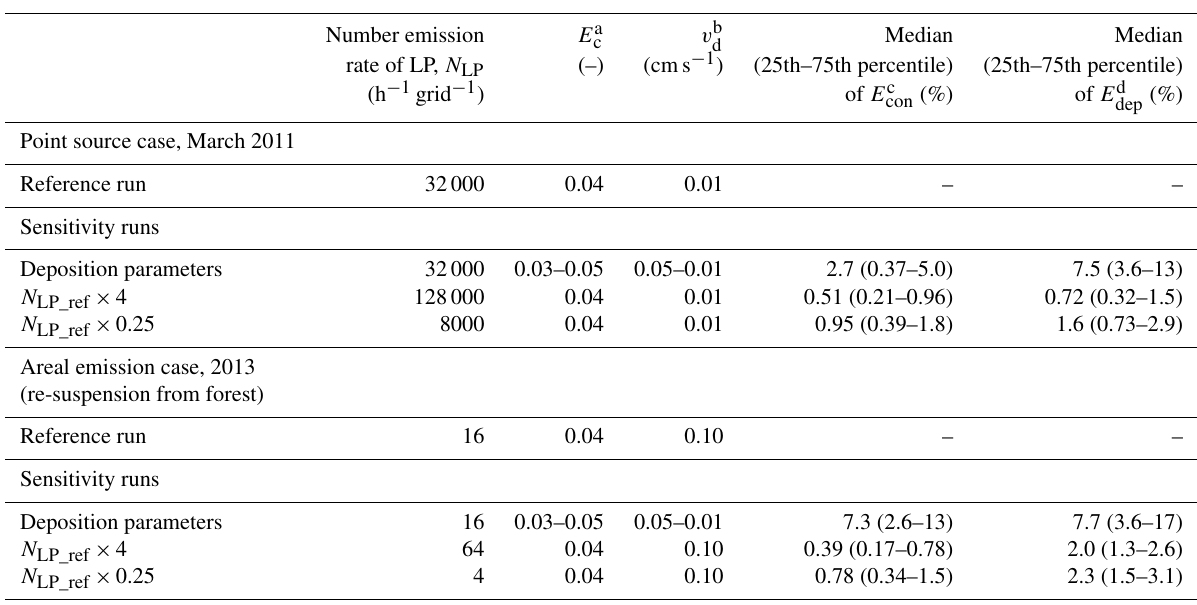
Table B1. Statistical measures of temporal mean 137 Cs surface concentration ( E con ) and cumulative deposition ( E dep ) of the sensitivity runs against the reference run for (top) the point source case and (bottom) the areal emission